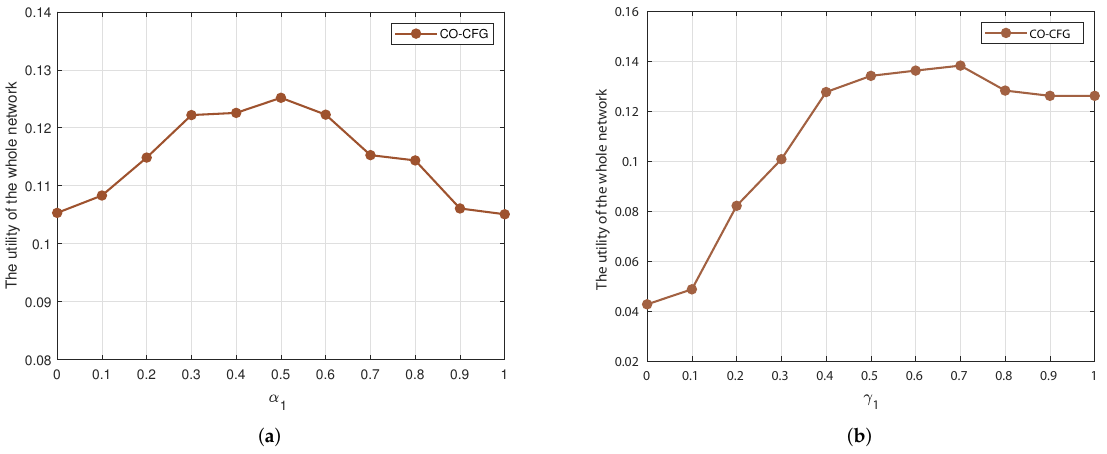
Figure 2. Impact of different ( a ) α 1 and ( b ) γ 1 on the utility of the whole network. ( a ) The effect of α 1 on the utility of the whole network. ( b ) The effect of γ 1 on the utility of the whole network.